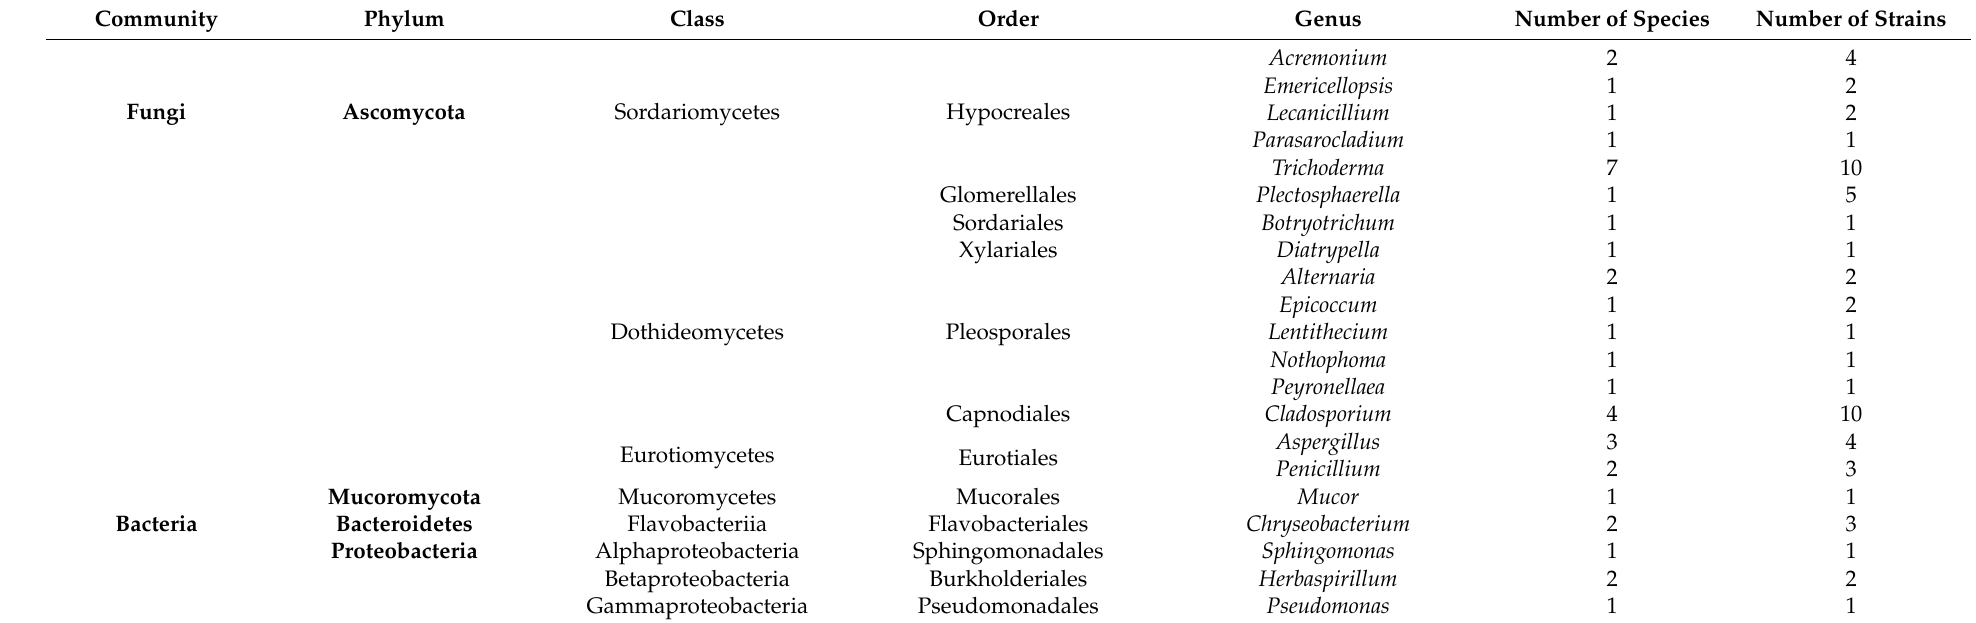
Table 1. Taxonomic groups of fungi and bacteria isolated from sediments of the Julong hot springs.